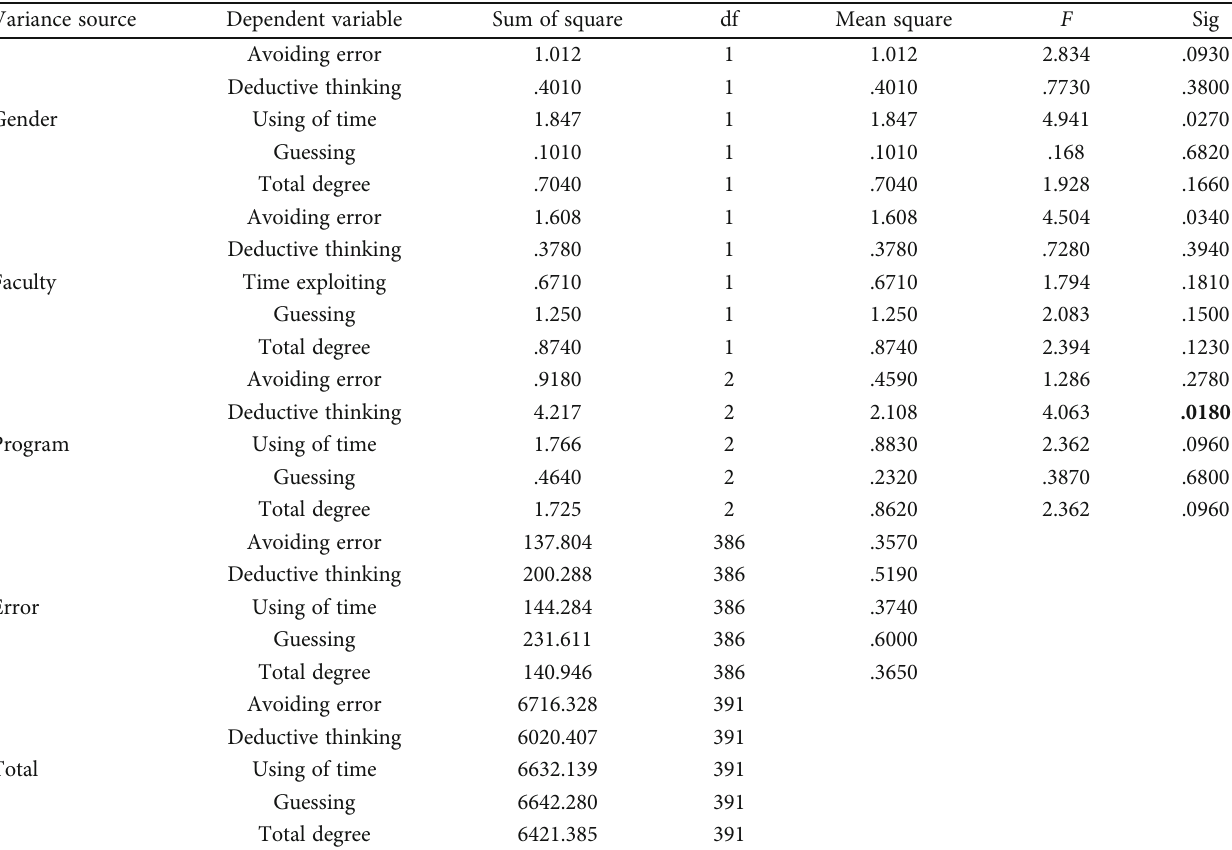
Table 6: (MANOVA) test results to examine the signi fi cance of the di ff erences between the arithmetic means of test wiseness according to (gender, faculty, and academic program).